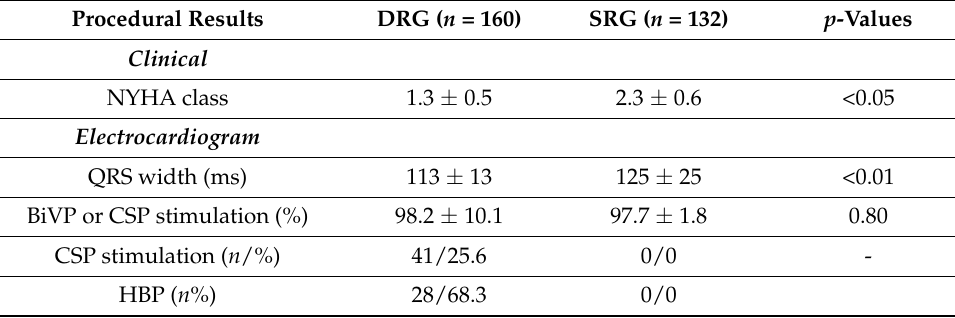
Table 3. Primary (composite outcome) and secondary (echocardiographic response and NYHA class) endpoints stratified for DRG and SRG.